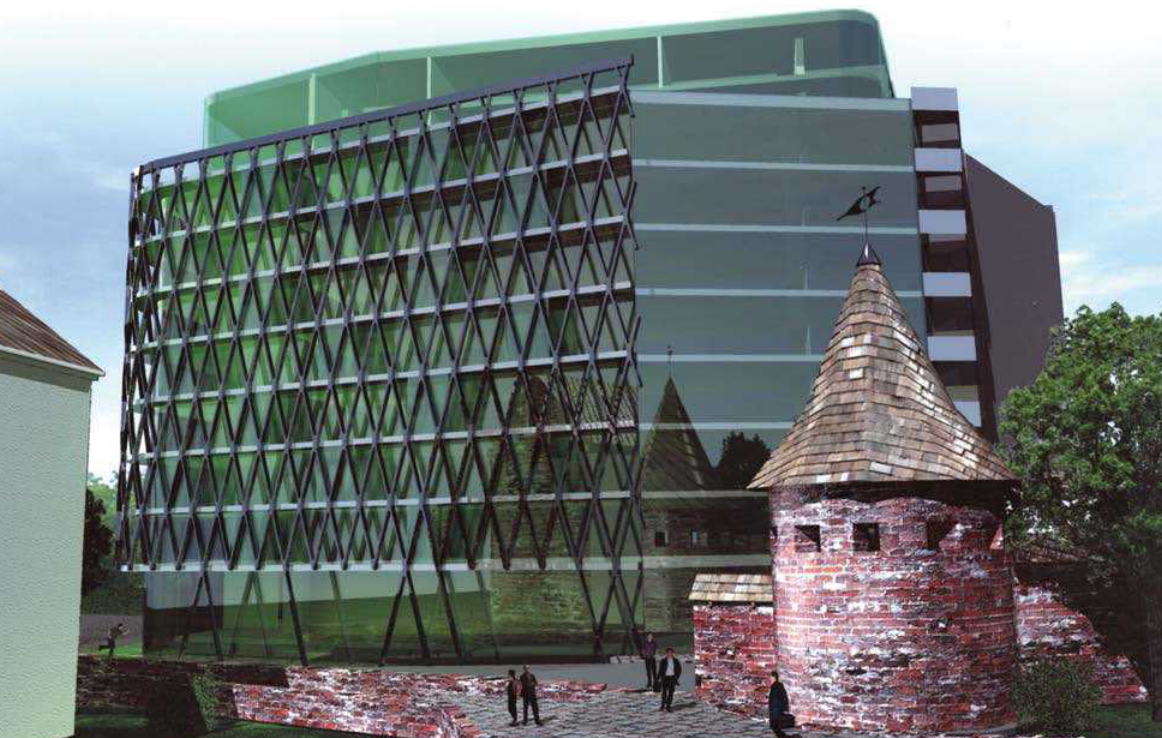
Fig 5. Improving visual exposition of Kaunas Town Defensive Wall and Tower by refl ectional effects of the fasade of newly constructed building serving as expositional (respect)